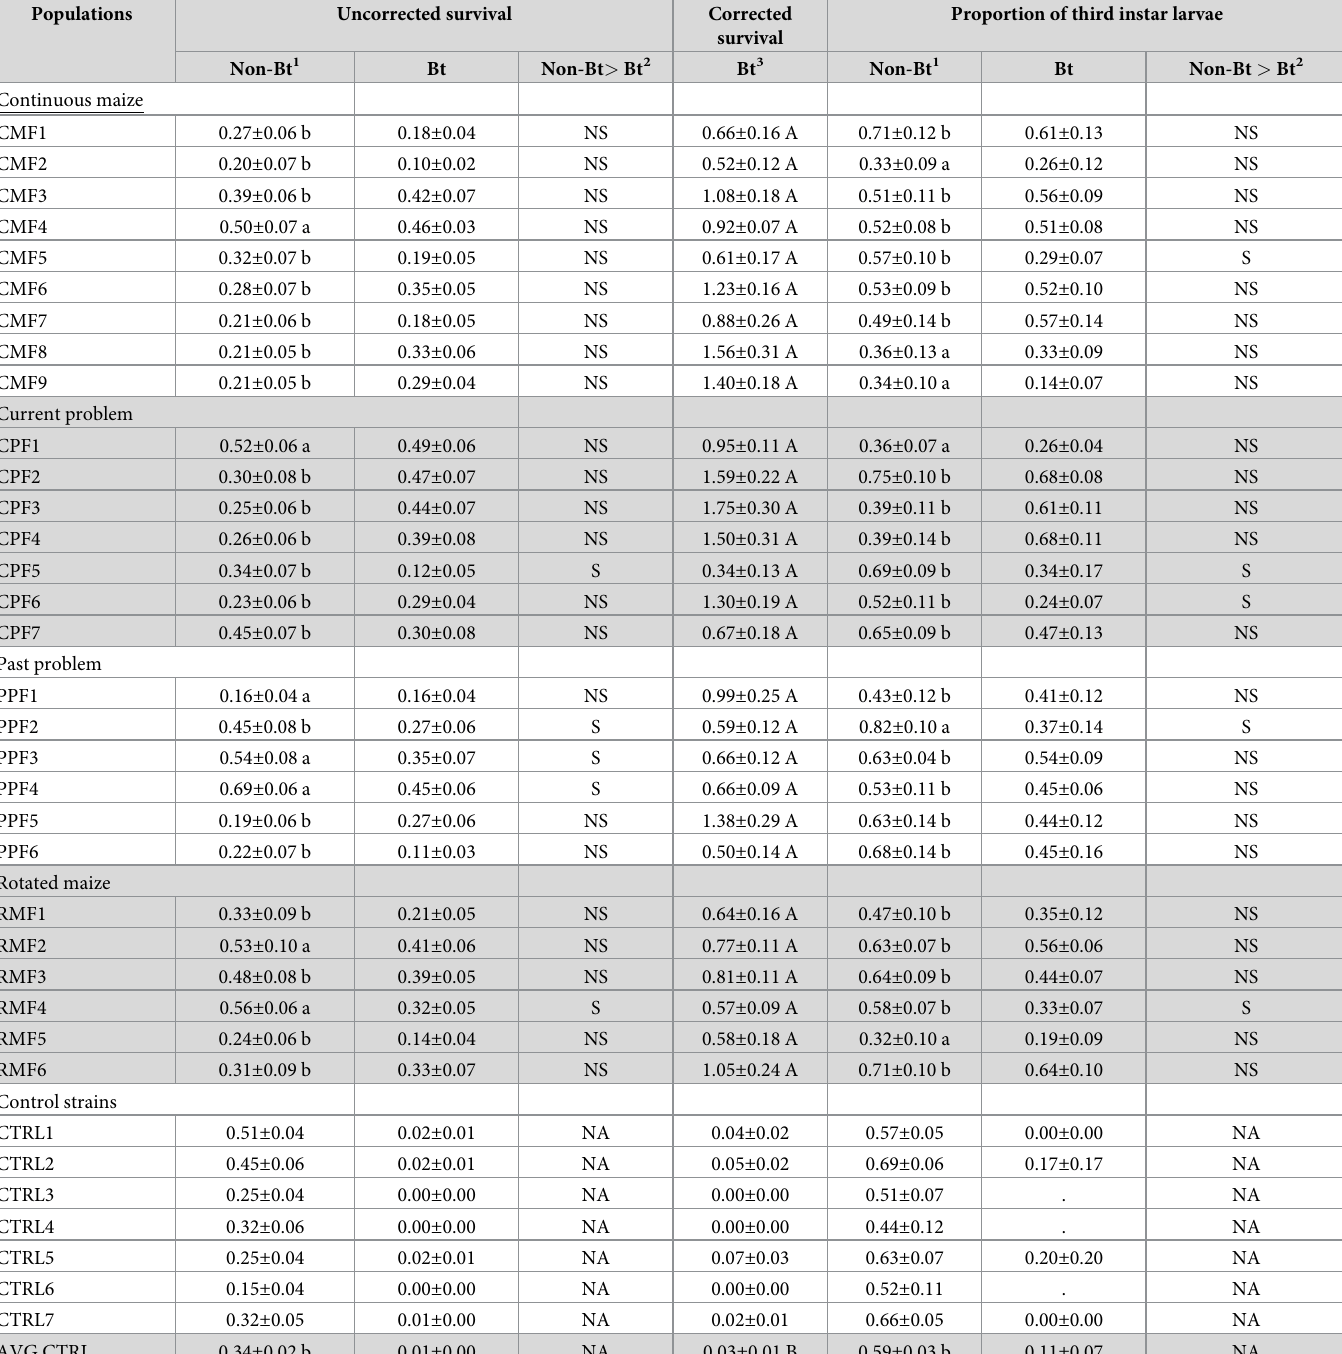
Table 3. Larval survivorship of western corn rootworm in plant-based bioassays.